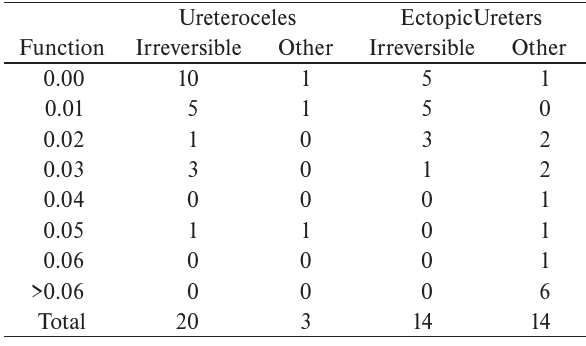
Table 1. Number of patients with ureteroceles or ectopic ureters according to the upper pole function and severity of the upper pole histological lesions.